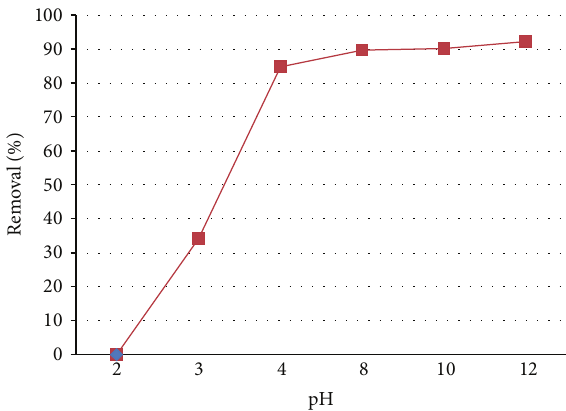
Figure 5: Effect of the pH on the removal of Copper (II) ion using Schiff base.